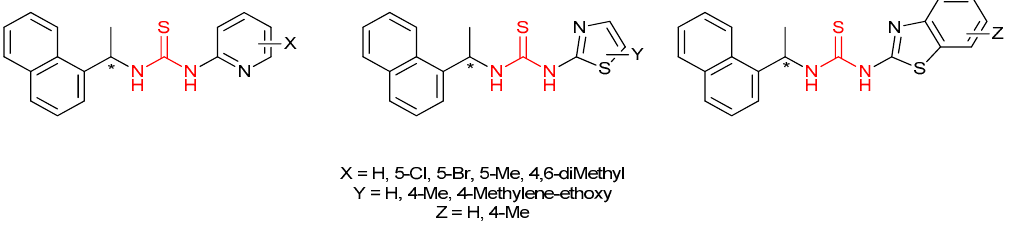
Figure 38. A series of chiral naphthyl thioureas tested as anti-HIV agents [368,369].